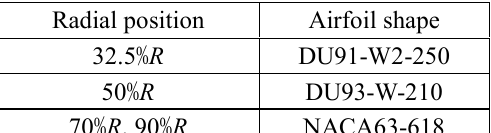
Table 1. Airfoil shape